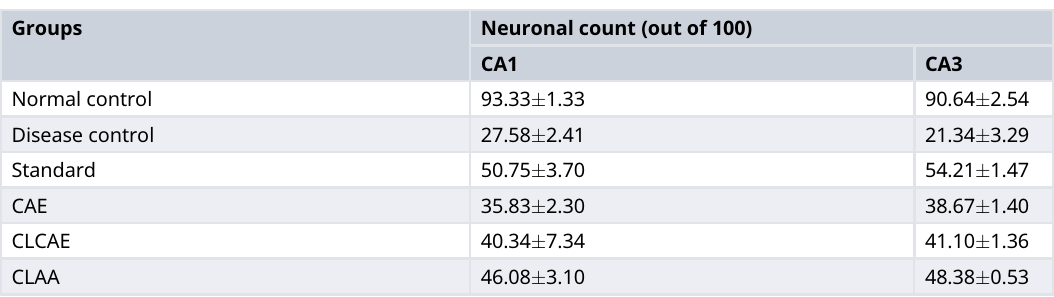
Table 4. Neuronal count (out of 100) in CA1 and CA3